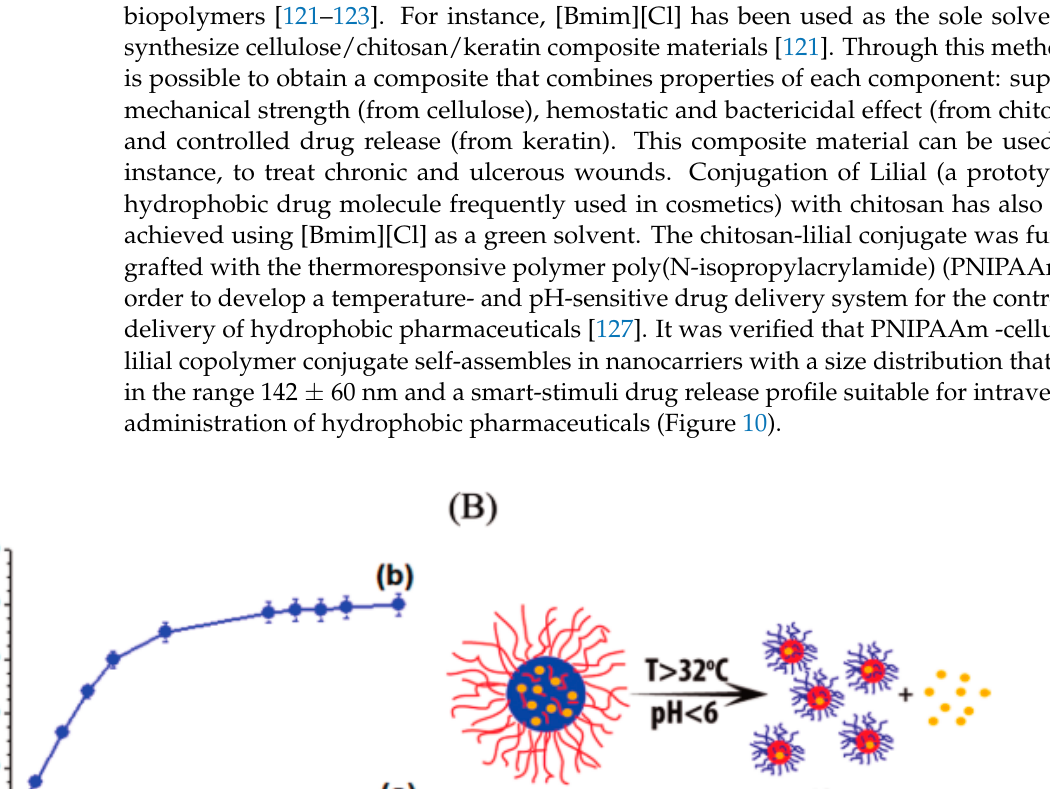
Figure 11. ( a ) In vitro release profile of a:5-FU loaded Ca- alginate/chitin nanofibers bio-nanocomposite gel beads and b: calcium alginate beads. Reprinted with permission from [122]. ( b ) Release profile of the rutin-loaded IL-PLGA nanoparti- cle hybrid systems during 72 h in phosphate buffer saline at pH 7.4. Data represented as mean ± SD ( n = 3). Reprinted with permission from [114].